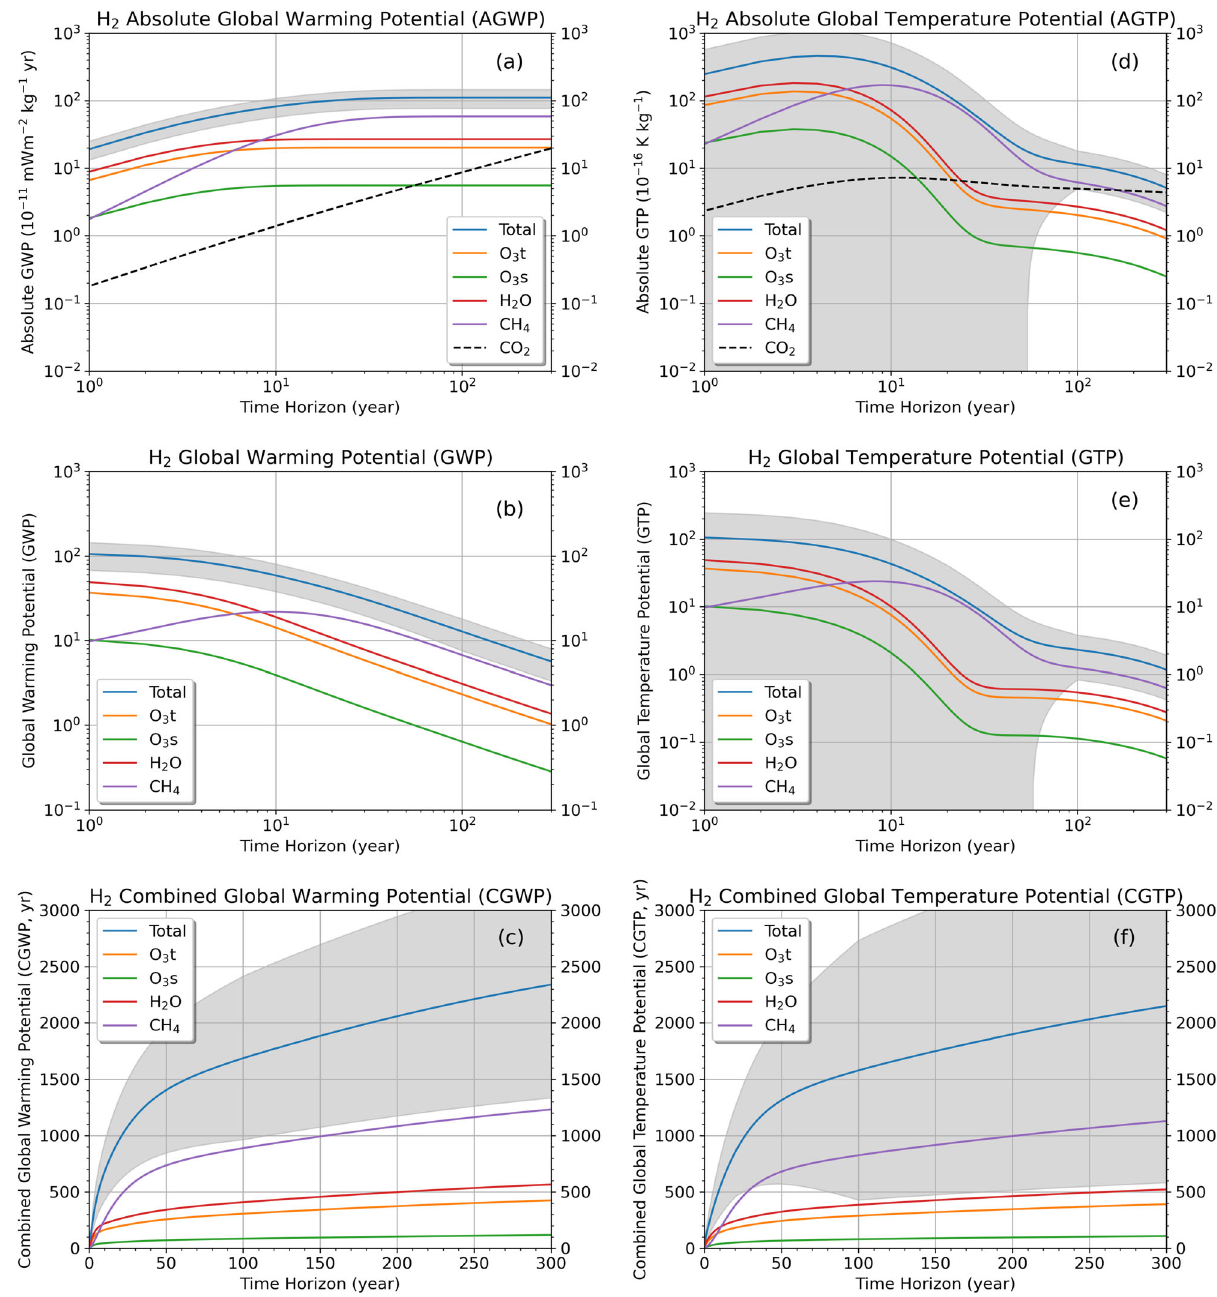
Fig. 1 Hydrogen climate metrics as a function of the considered time horizon. a Absolute GWP (AGWP, in 10 − 14 W/m 2 /kg year) and d Absolute GTP (AGTP, in 10 − 16 K/kg); b GWP (unitless) and e GTP (unitless); and c CGWP (year) and f CGTP (year) for hydrogen as a function of time-horizon. The total metrics (blue solid line) are decomposed into their tropospheric ozone (O 3 t), stratospheric ozone (O 3 s), stratospheric water vapour (H 2 O), and methane (CH 4 ) components (see legend for colouring). The metrics are calculated for a pulse emission of 1 Tg of hydrogen. The AGWP and AGTP for CO 2 are also illustrated for comparison. Uncertainty calculations are presented in Supplementary Table S2 and 90% con fi dence level are represented as a shaded area for the total